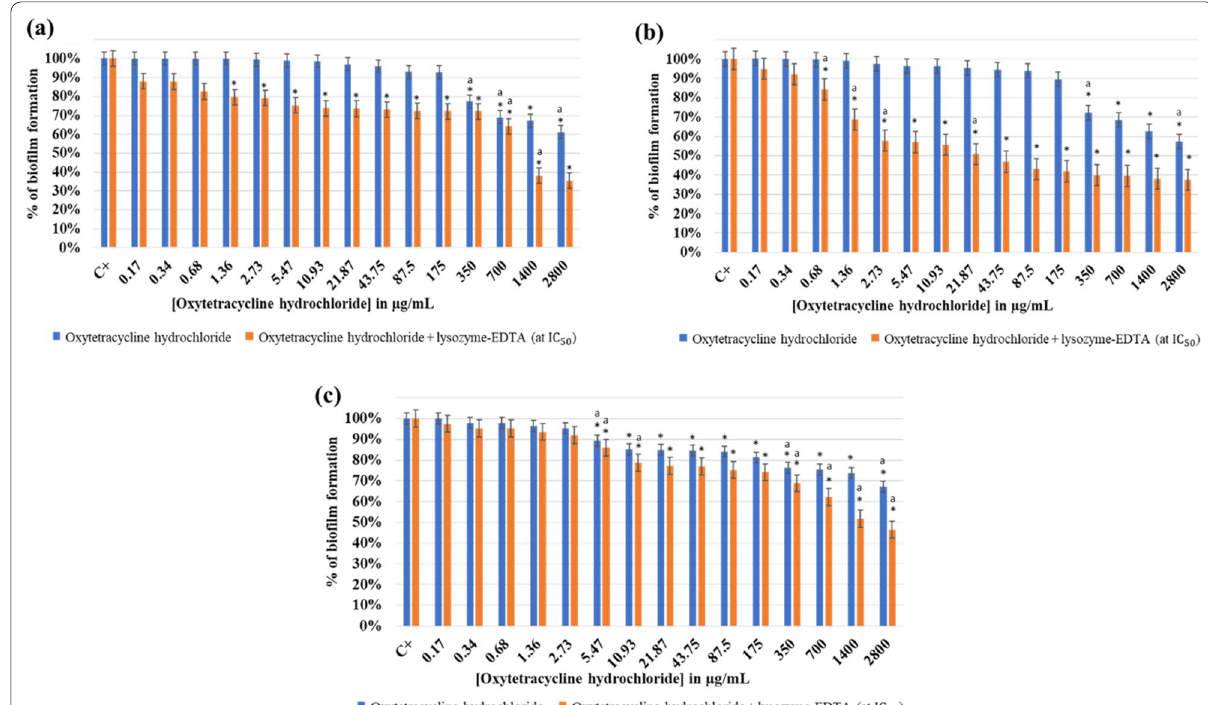
Fig. 8 Effect of oxytetracycline hydrochloride with and without lysozyme-EDTA (at MCBEC 50 ) on different biofilms at pH7.5. a Lactobacillus rhamnosus GG, b Staphylococcus epidermidis 444, and c co-culture of both strains. The results are mean values of three replicates. (*) indicates a significant difference (P < 0.05) between each test and the positive control (oxytetracycline hydrochloride). The lowercase letter a indicates a significant difference (P < 0.05) between each test and its preceding. Error bars represent the SD (standard